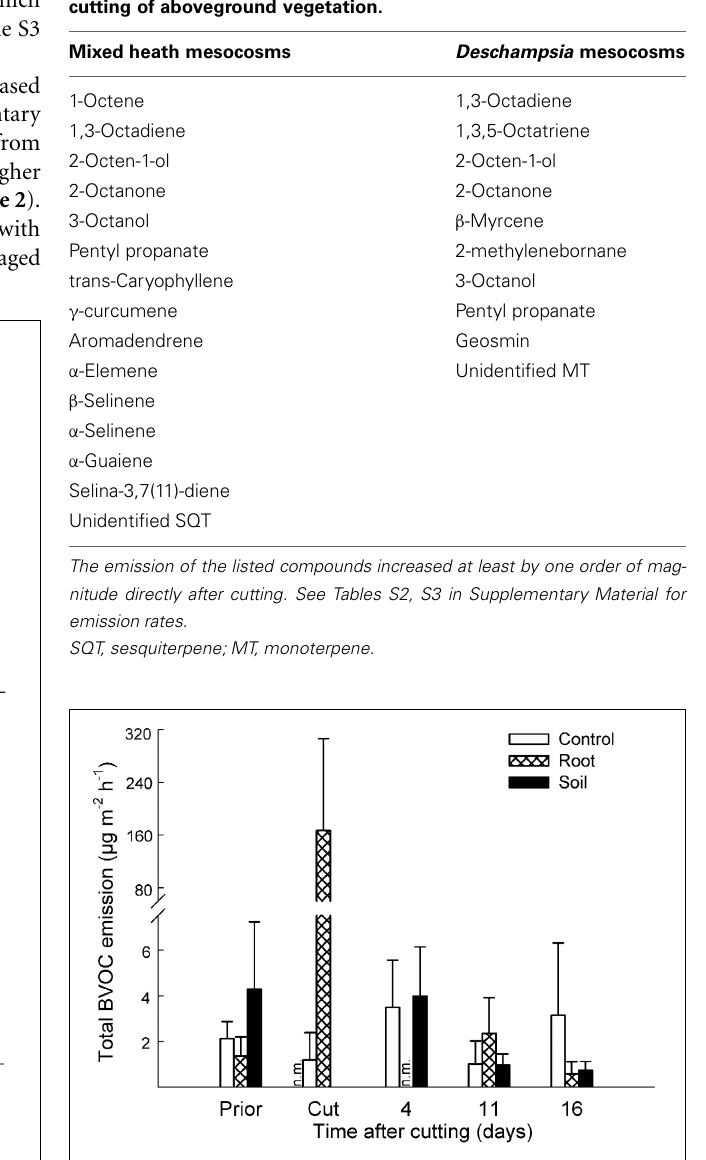
FIGURE 3 | Effect of experimental manipulations on biogenic volatile organic compound (BVOC) emissions from Deschampsia mesocosms. The total emissions of BVOCs (mean + SE, n = 3) with intact vegetation (control), cut abovegroundvegetation (root mesocosms) and all vegetation removed (soil mesocosms) prior to cutting (Prior), directly after cutting (Cut) and after cutting at different time intervals. n.m., not